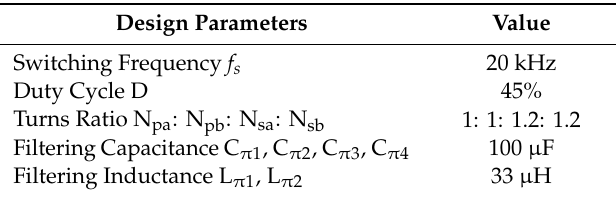
Table 1. Experimental design parameters.